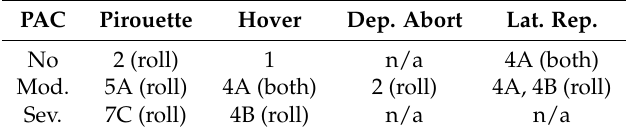
Table 8. Summary of PAC PIO detection w.r.t. pilot ratings.